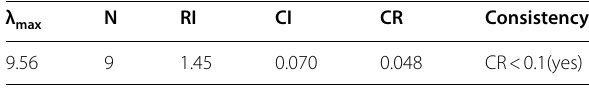
Table 7 Consistency check result of all thematic